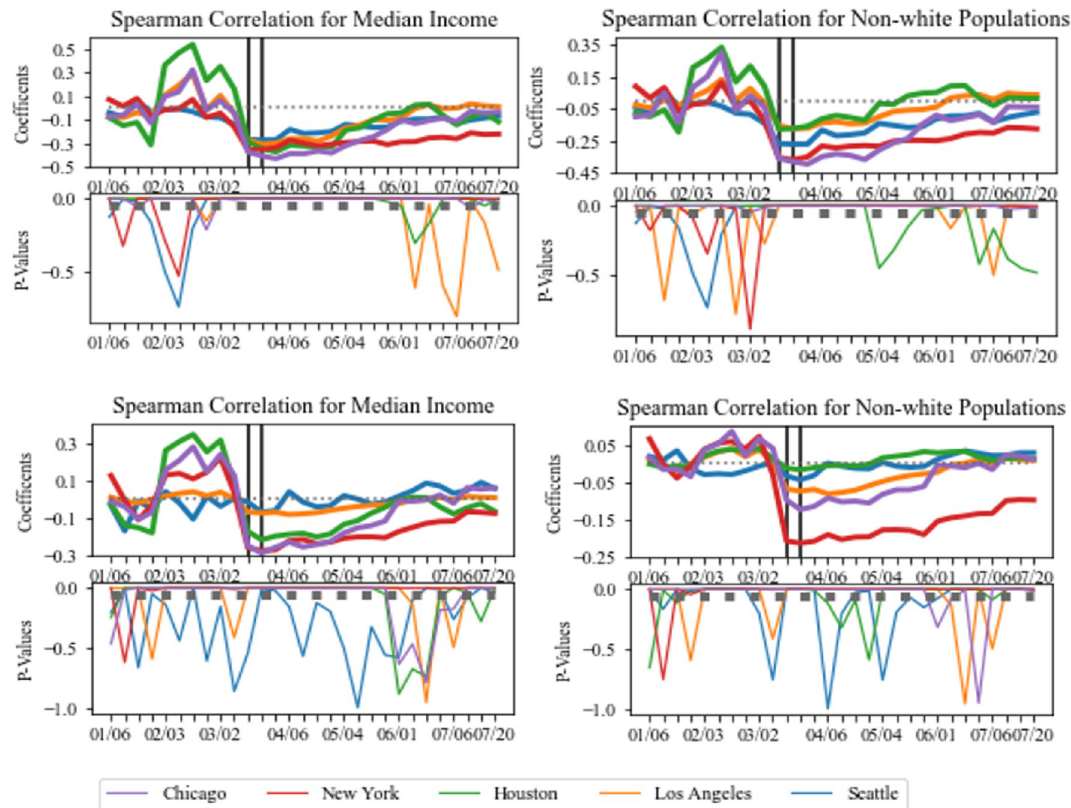
Figure 5. (Top) Spearman correlations of population activity fluctuations against median income levels and nonwhite populations of POI cbgs. (Bottom) Spearman correlations of POI-CBG network against median income levels and nonwhite populations of home cbgs. The two vertical black lines indicate the weeks when NPIs implemented since this varied for the five urban locations. p-values are statistically significant at p < 0.05.